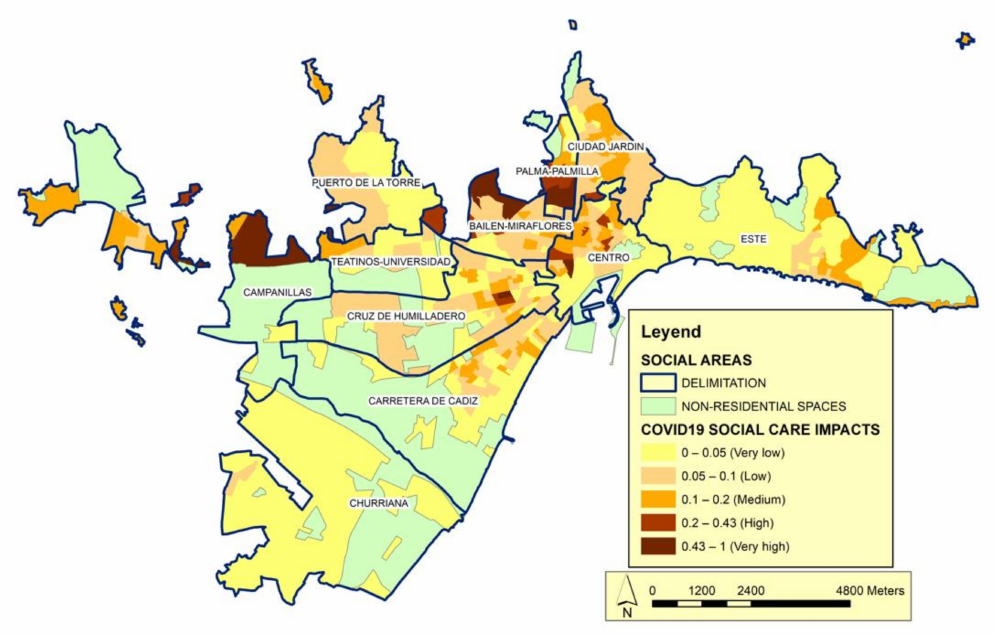
Figure 7. Distribution of the impact of COVID-19 according to the Social Care category. Source: Author’s elaboration. The impact index shows the correlation between Social Care vulnerability calculated according to the variables of this category in relation to the number of